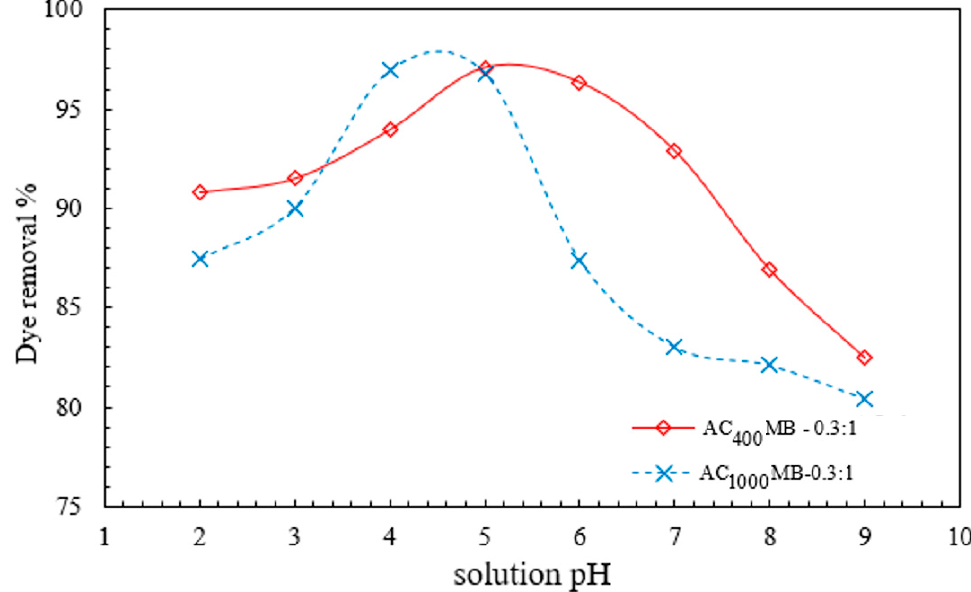
Figure 10. The effect of pH on DB78-dye-removal efficiency using AC 400 ◦ C MB-0.3:1 and AC 1000 ◦ C MB-0.3:1.